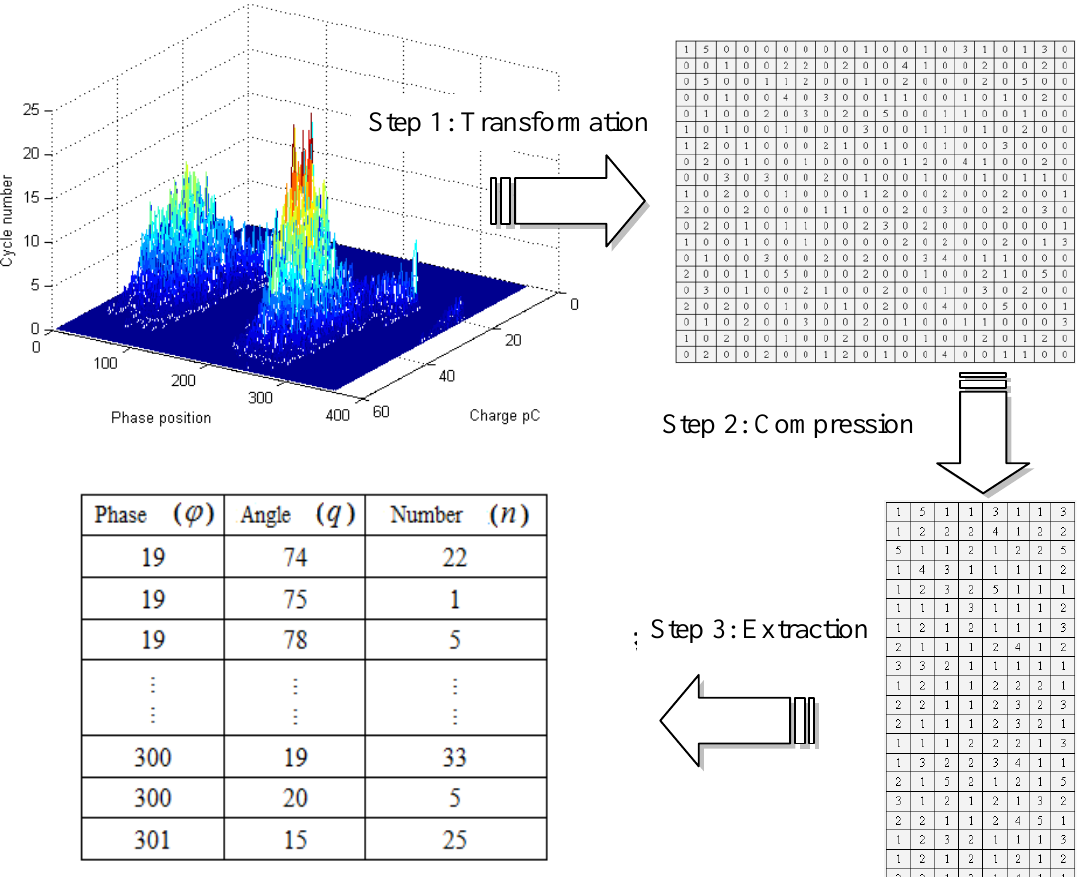
Figure 13. Three steps of data transformation for 3D PD pattern.